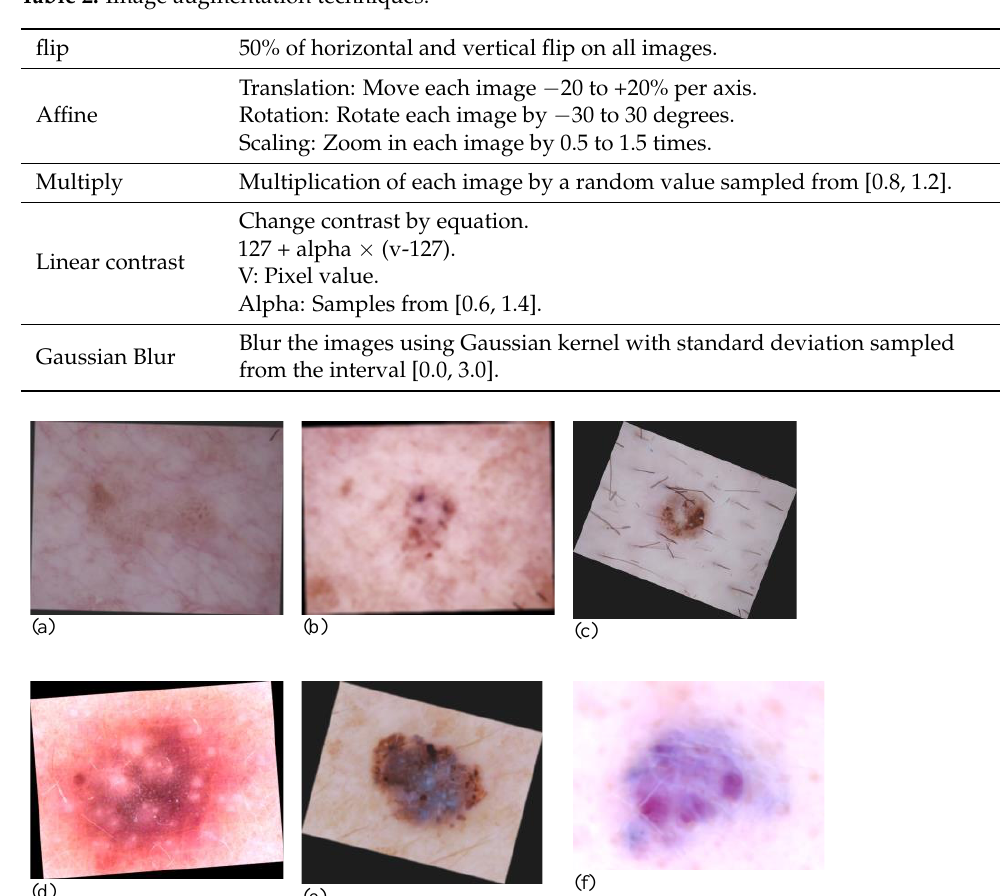
Figure 3. Augmented images. ( a ) AKIEC; ( b ) BCC; ( c ) BKL; ( d ) DF; ( e ) MEL; and ( f ) VASC.